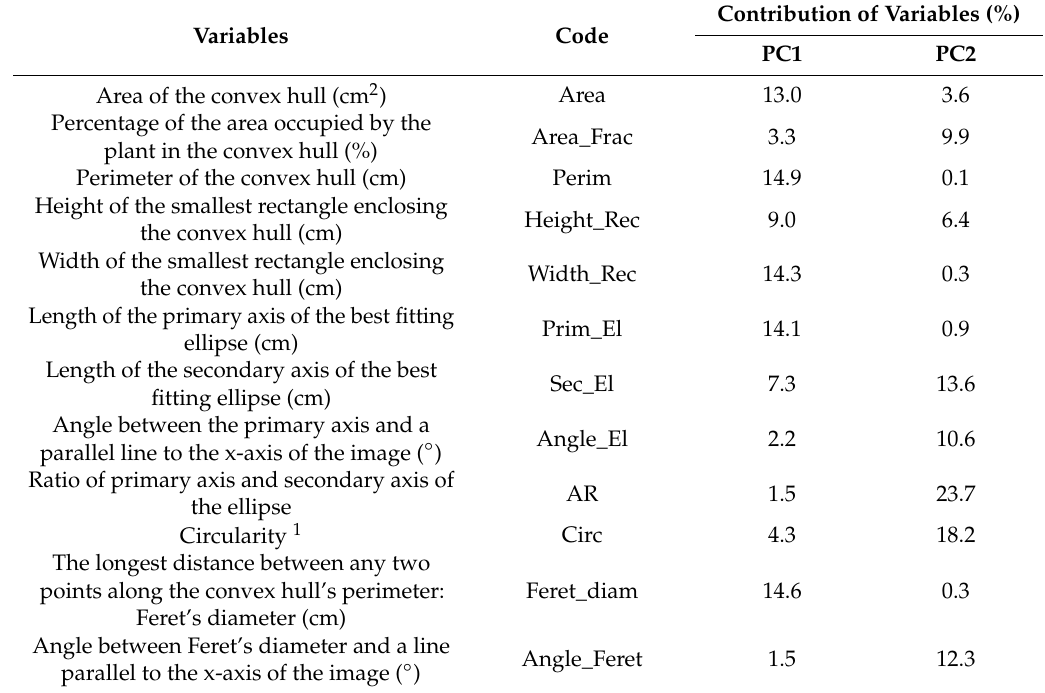
Table 2. List of the morphometric variables measured and the contribution of these variables to the formation of principal components (PC) 1 and 2 of the principal component analysis.